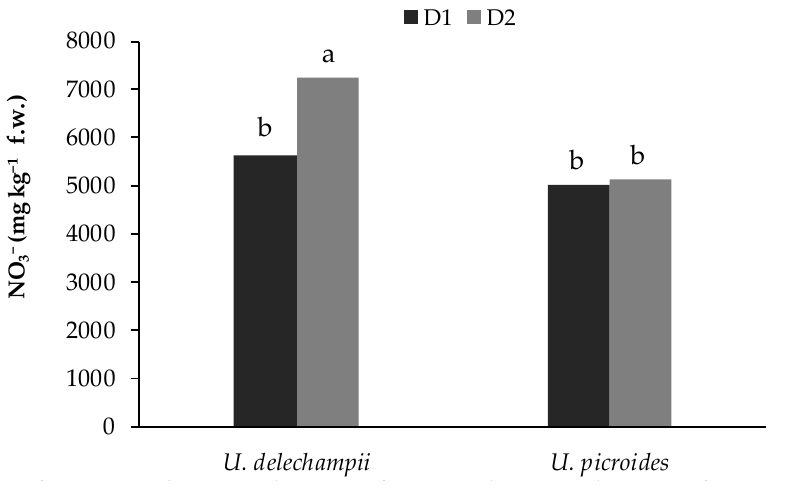
Figure 3. Nitrate content in U. delechampii and U. picroides grown at two plant densities: 824 plants m −2 (D1) and 412 plants m −2 (D2). The same letters indicate mean values not significantly different ( p = 0.05).